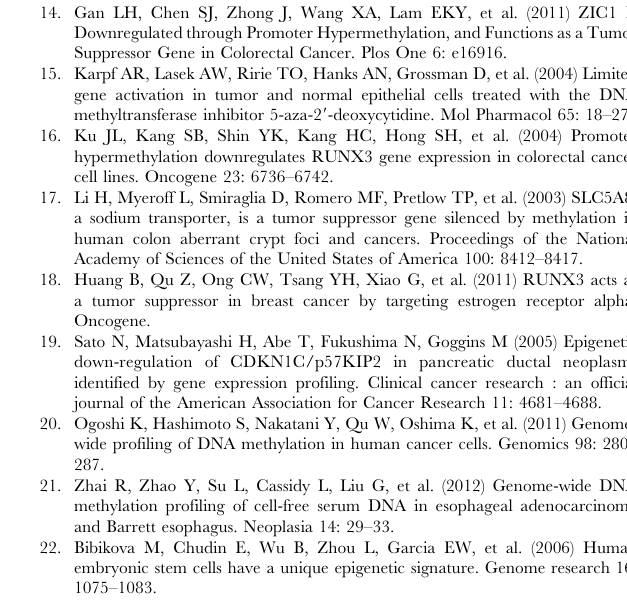
Figure S2 (A) Results of bisulphite sequencing on the PTGDR gene promoter region in case of normal and tumorous biopsy samples, and HT-29 cell line. This region contains 24 CpG dinucleotides, which are potential targets of methyl-transferases. In normal samples only converted cytosines were detected with higher T peak (red) (see the chromatogram of a representative normal sample). In tumorous samples higher C peaks (blue) were observed in position 2, 8, 9, 14, 15 and 23 which originate from the non-convertible, methyl group containing cytosines. In the HT-29 cell line this region was found to be completely methylated (non-convertible). (B) Methylation status heatmap of the examined CpG positions by bisulphite sequencing data. Black and white rectangles are indicate the totally methylated (100%) and unmethylated (0%) CpG positions, respectively. Figure S3 PTGDR immunohistochemistry on tumor samples. Although low PTGDR protein level was observed in most tumor epithelial samples (see Figure 5), in some well differentiated early stage CRC cases strong dark brown staining (representing high PTGDR protein expression) could be detected (indicated by red arrows). Figure S4 Euclidean distance analysis performed on the GSE18105 dataset. The aim of this analysis was to clarify the reason for the misclassification of sample GSM452639 in the PCAs. There were no alterations in microarray QC parameters including histogram of fluorescence intensity, RNA degradation and proportion of GAPDH and ACTB transcripts 3 9 /5 9 intensity ratios. However, the Euclidean distance calculation using 17 normal and 17 homogenized CRC tissue samples from the GSE18105 dataset resulted in clear separation of normal and tumorous samples. One of the normal samples (GSM452639, indicated by an arrow) which was also found to be an outlier in PCA, generates a distinct cluster in the distance analysis. This indicates that the misclassification of this sample could be resulted from an error in the sample collection or sample handling process.